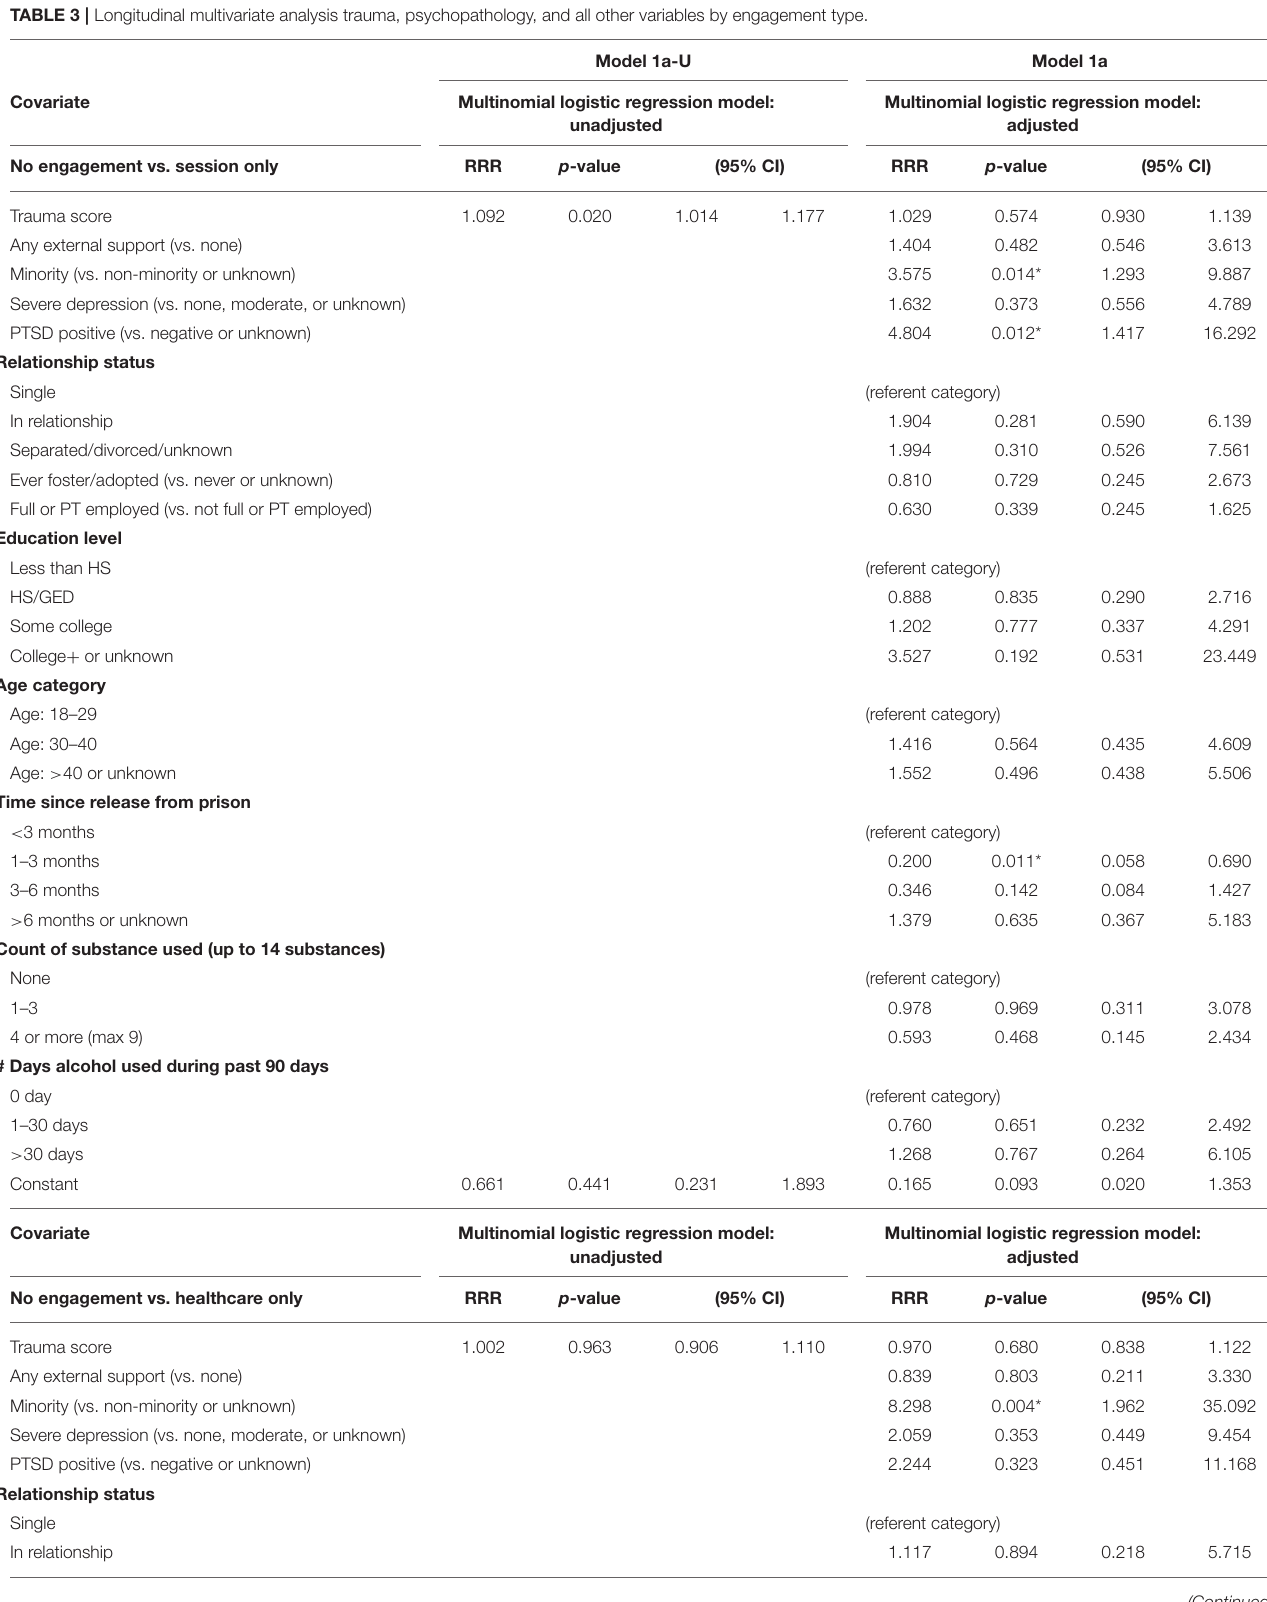
TABLE 3 | Longitudinal multivariate analysis trauma, psychopathology, and all other variables by engagement type. Covariate Multinomial logistic regression model: